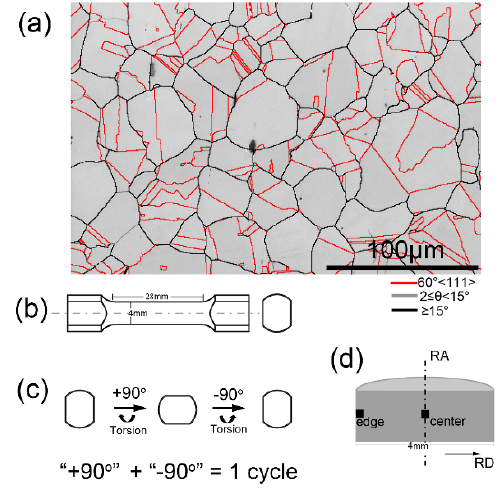
Figure 1. Microstructure before torsion ( a ), sample size of torsion processing ( b ), processing schematic ( c ), and locations of microstructure characterization ( d